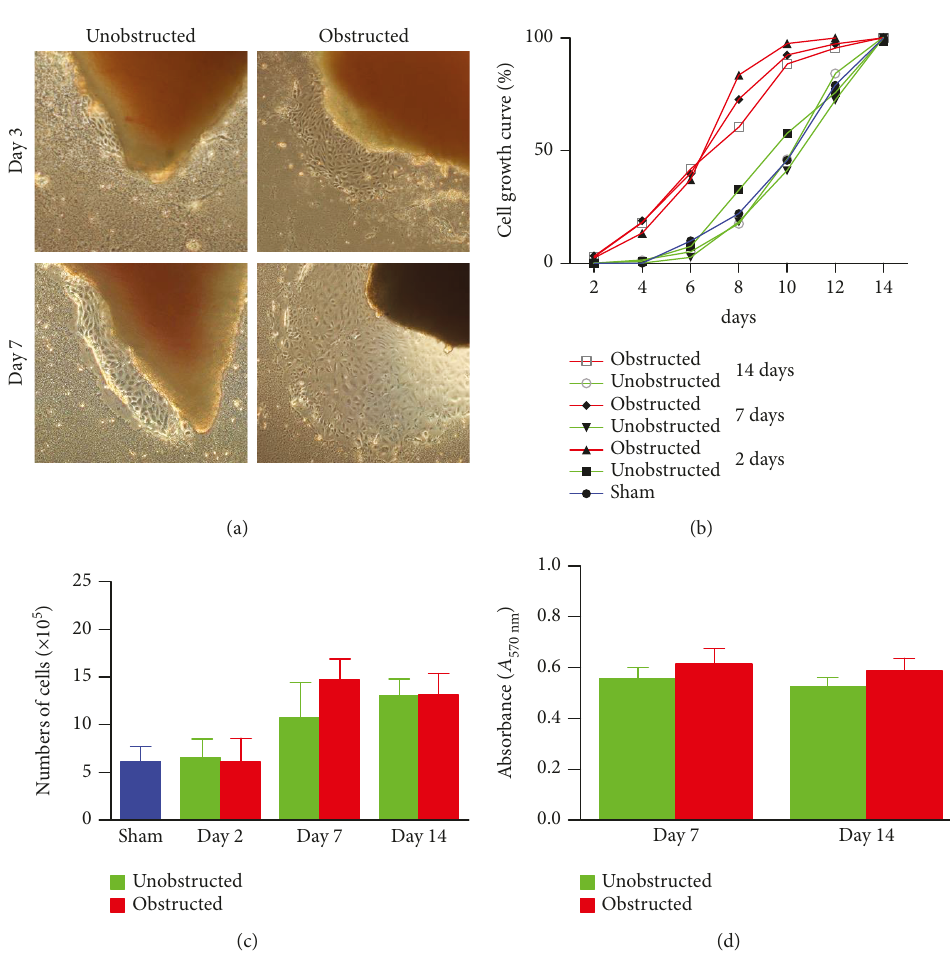
Figure 2: Dynamics of cell outgrowth from renal tissues by culturing as “ explants. ” (a) Representative images show the outgrowth of cells from the “ explants ” of renal tissues at 3 and 7 days after planting on the dish. (b) The curve lines represent the percentages of “ explants ” with cell growth at di ff erent times (days) after the initiation of culture in each group. (c) The numbers of outgrowth cells harvested at 14 days after the initiation of culture. (d) MTT assay on the proliferation of twice-passaged